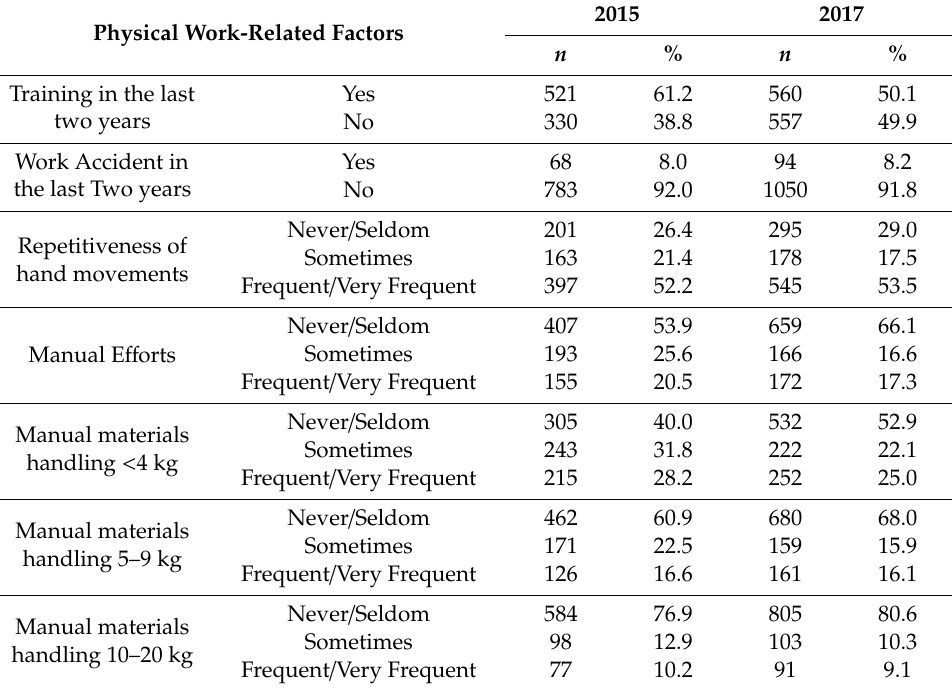
Table 3. Training in the last two years, work accident in the last two years, repetitiveness of hand movements, manual e ff orts, manual materials handling below 4 kg, manual materials handling 5–9 kg, and manual materials handling 10–20 kg by the study participants in 2015 and 2017.